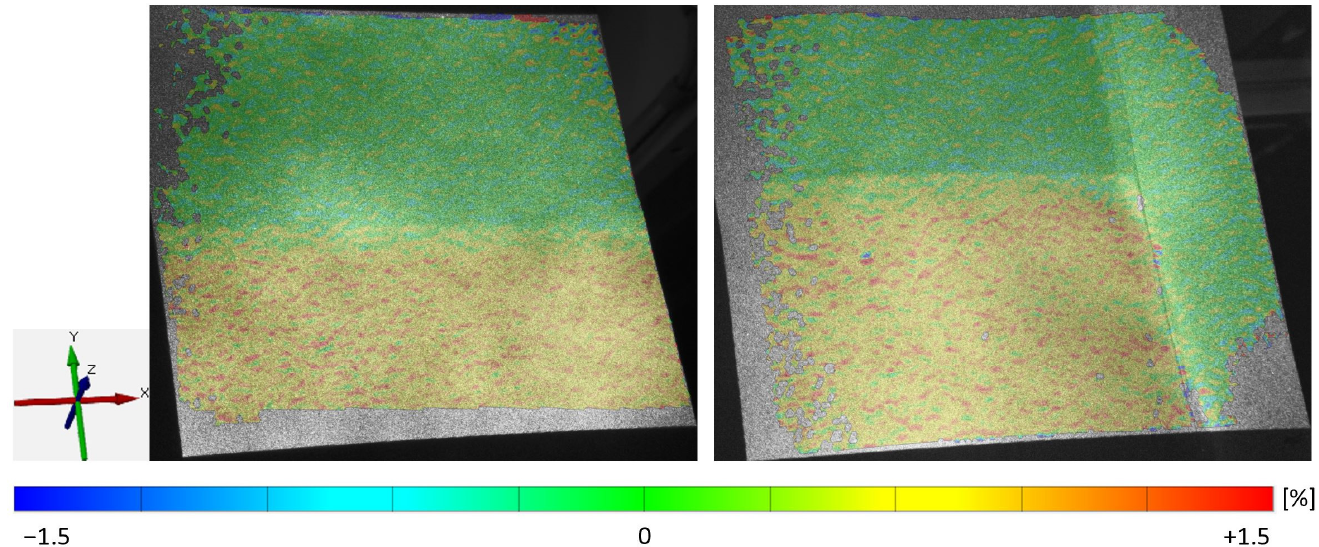
Figure 10 . Experiment No. 7 and 11: Influence on the y-elongation by the uncalendered area (top half) and the uncoated collector (right edge) .